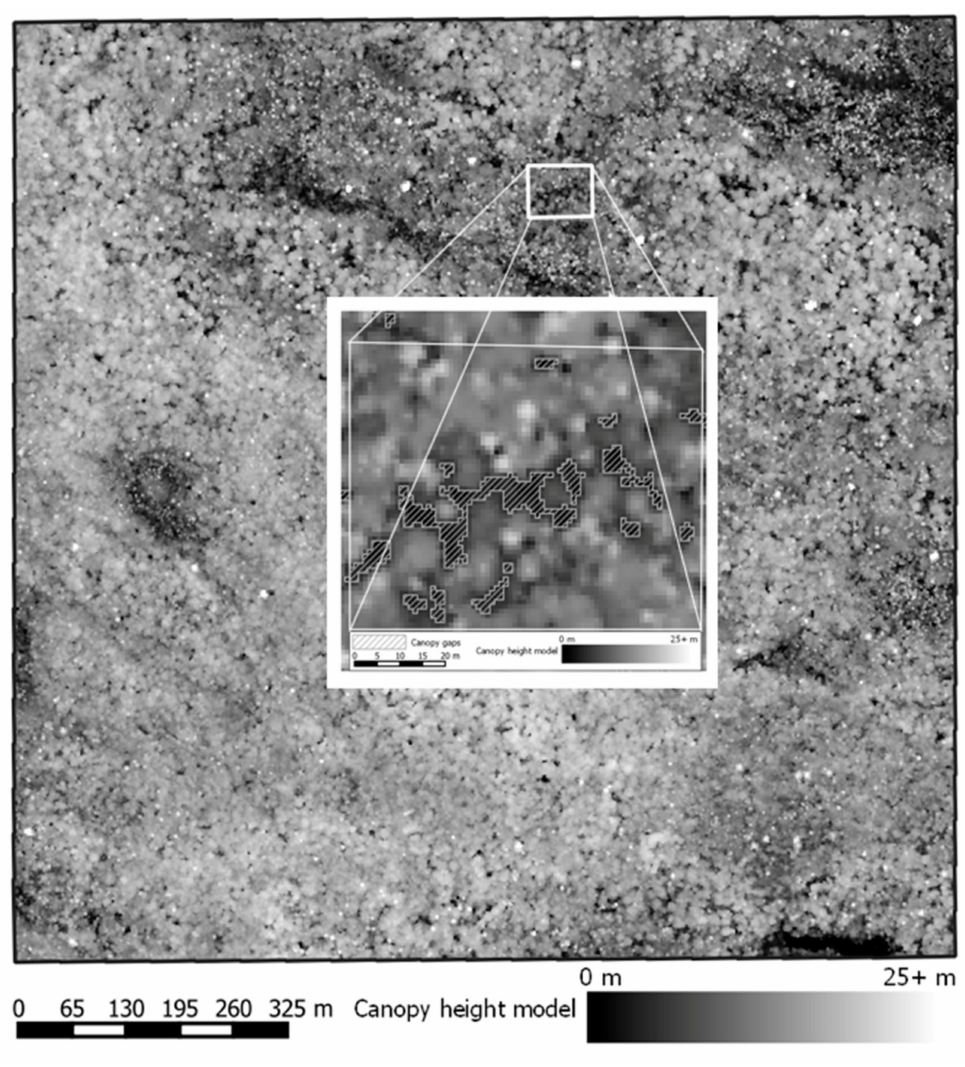
Figure 2. Example (landscape no. 89, see Figure 1a for its exact position in the southeast of the study area) of a canopy height model derived from aerial LiDAR data used to detect forest gaps (hatched zones in the insert) (gap height threshold = 5